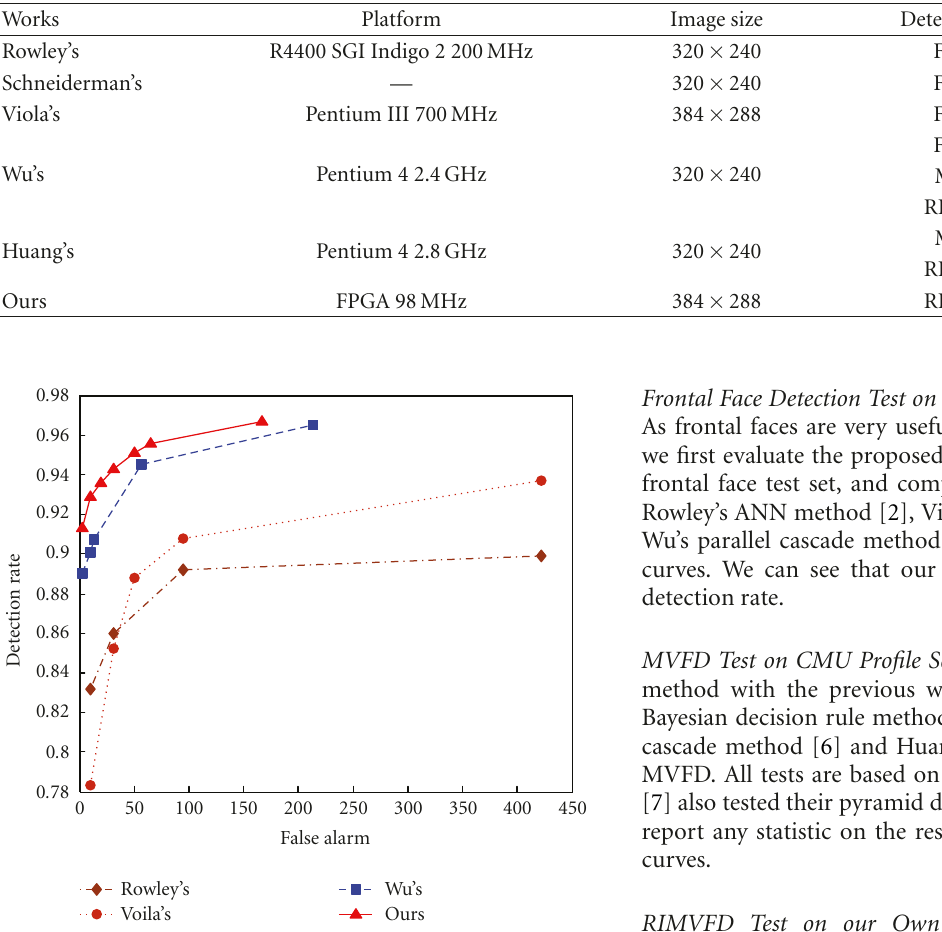
Figure 14: ROC curves on CMU + MIT frontal face